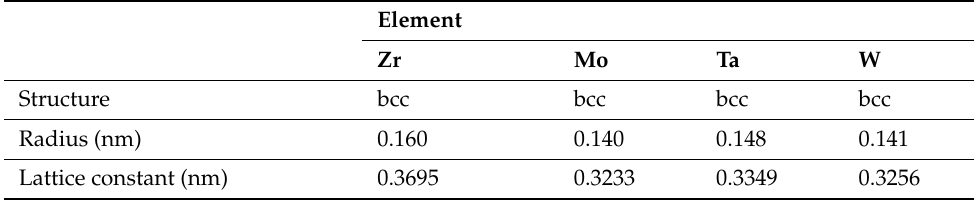
Figure 5. ( a ) XRD patterns of Zr-Mo-Ta-W RMPEA thin films, and ( b ) enlarged view of samples E8, I5, F6C, C5, and E4 between 40° and 50°. Table 2. Structure, atomic radius, and lattice constant of Zr, Mo, Ta, and W elements in the ZrMoTaW system